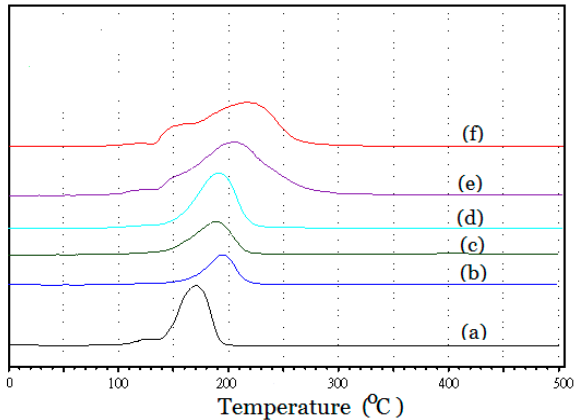
Figure 5. Temperature-programmed reduction (TPR) profiles of (a) Ru@SiO 2 core-shell-particles with a Ru/Si atomic ratio of 0.4 (without Re addition) and Re-Ru@SiO 2 core-shell-particles with Ru/Si atomic ratios of (b) 0.1, (c) 0.2, (d) 0.4, (e) 0.8 and (f) 1.6.